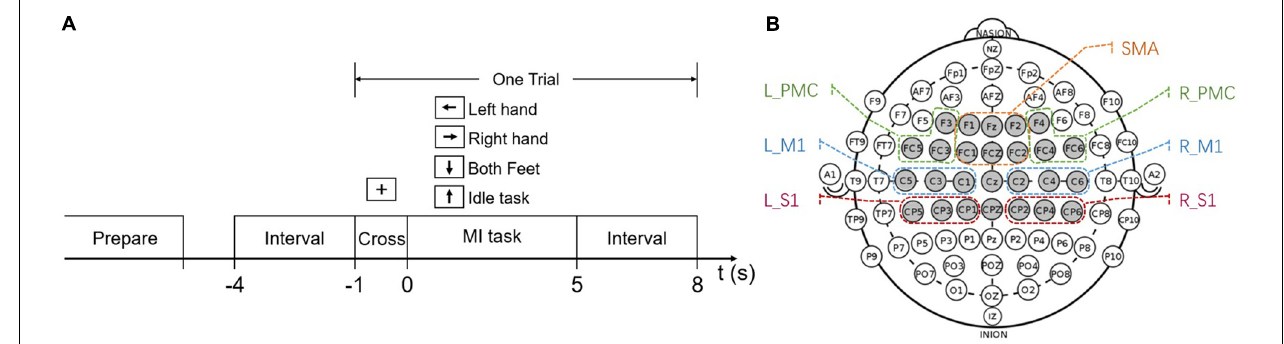
FIGURE 1 | (A) MI-BCI experiment paradigm. (B) Chosen electrodes (gray) in the international 10–20 system. The electrodes are artificially grouped into different brain regions according to their location and marked in the figure. SMA, supplementary motor area; L_PMC, left premotor cortex; R_PMC, right premotor cortex; L_M1, left primary motor cortex; R_M1, right primary motor cortex; L_S1, left primary sensory cortex; R_S1, right primary sensory